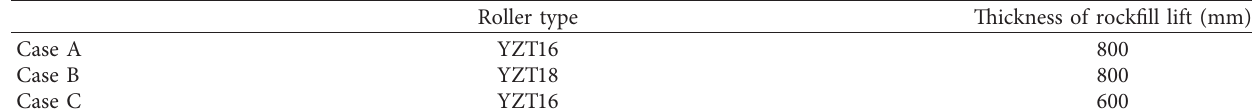
Figure 11: PSDs of field rockfill and numerical rockfill model. Table 4: Introduction of the three investigated cases.